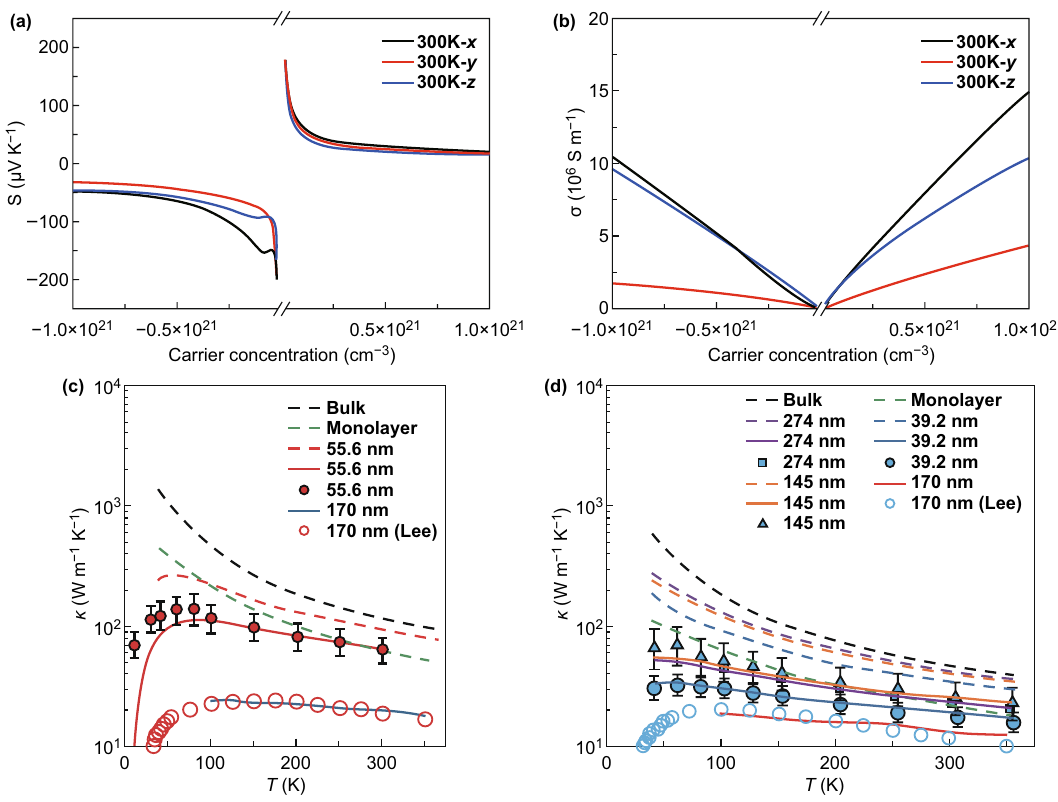
Fig. 3 a Calculated Seebeck coefficient and b electrical conductivity of a few-layer black phosphorus at T = 300 K. Reproduced with permission from Ref. [132]. Copyright 2016, Royal Society of Chemistry. Measured thermal conductivity of black phosphorus depending on their thickness and temperature along different directions: c zigzag direction, d armchair direction. The dashed lines and the solid lines correspond to the calcu- lation results for the defect-free black phosphorus and the black phosphorus with additional vacancy point defects, respectively. Reproduced with permission from Ref. [135]. Copyright 2017,